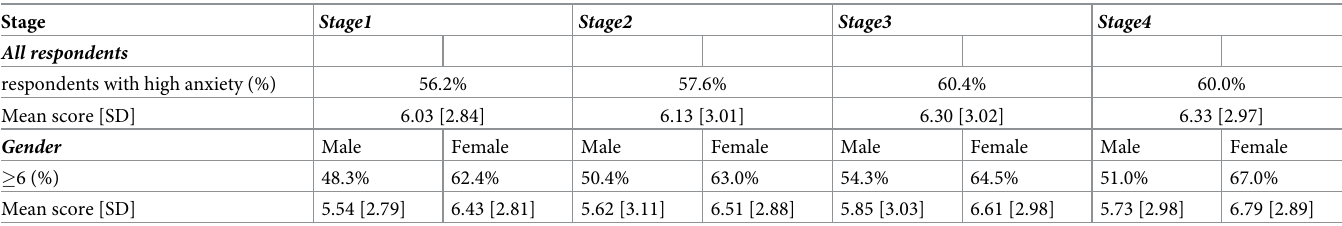
Table 2. Anxiety level statistics considering gender differences in each stage.